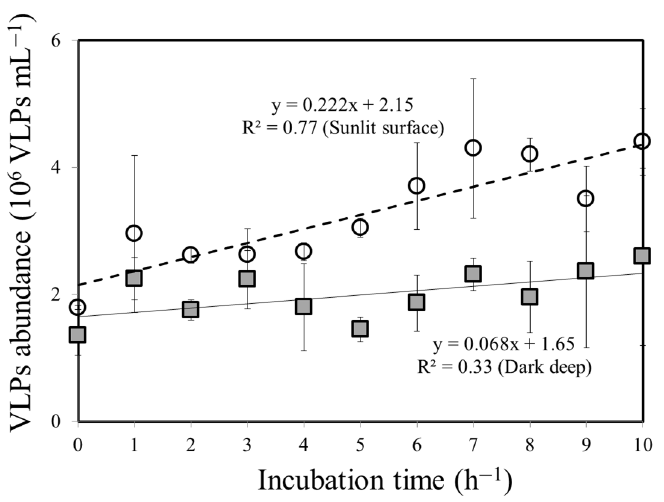
Figure 2. Relationship between VLP abundance and incubation time in the sunlit surface (O) and dark, deep ocean environment ( (cid:4) ). (—) and (—) are the regression lines for sunlit surface and dark dark, deep ocean environment ( ■ ). (---) and (—) are the regression lines for sunlit surface and dark deep water, deep water, respectively.